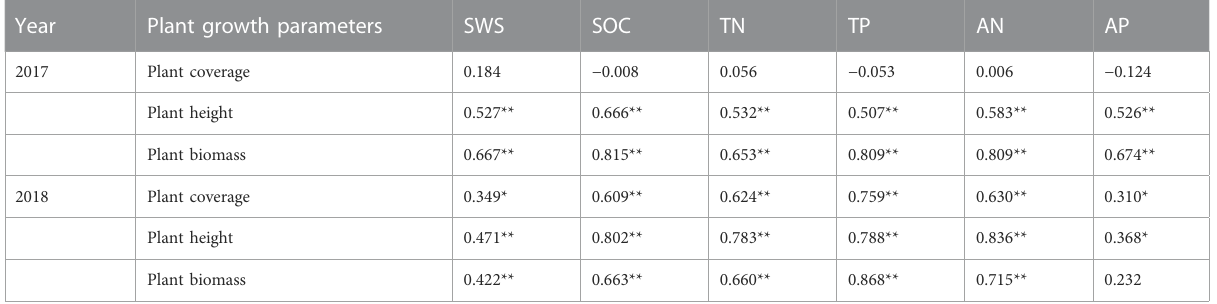
TABLE 2 The correlations between plant growth parameters and soil